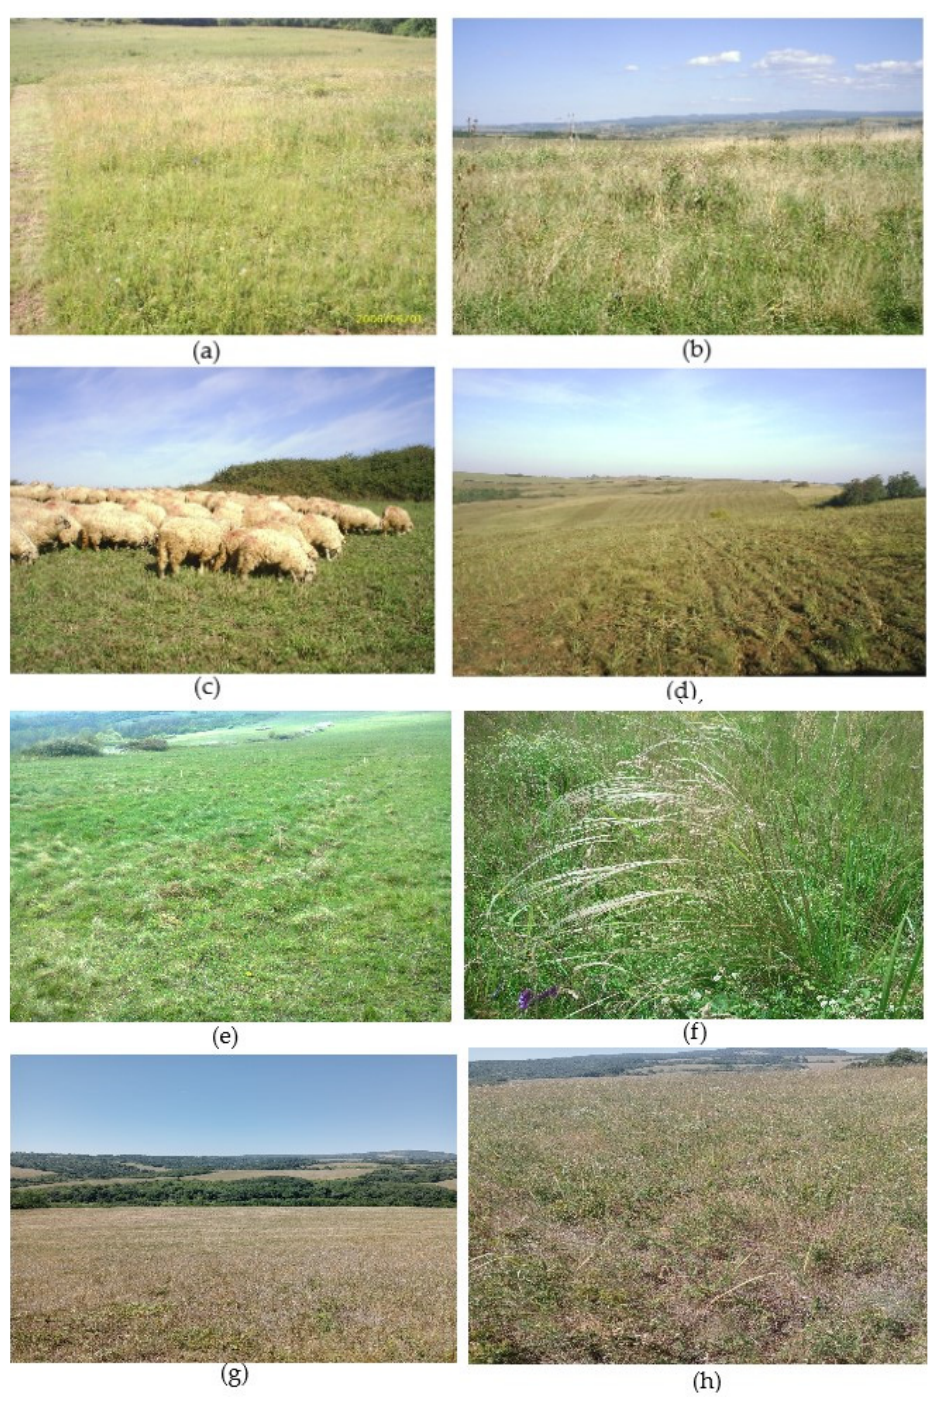
Figure 11. Successional ex-arable grassland from Gr ă dinari: ( a ) general view from 2006; ( b ) general view from 2007; ( c ) sheep grazing in 2007; ( d ) after mulching in 2007; ( e ) view from 2012; ( f ) Stipa capillata in 2015; ( g , h ) view from 2021 [photo: S ă r ăț eanu V.].